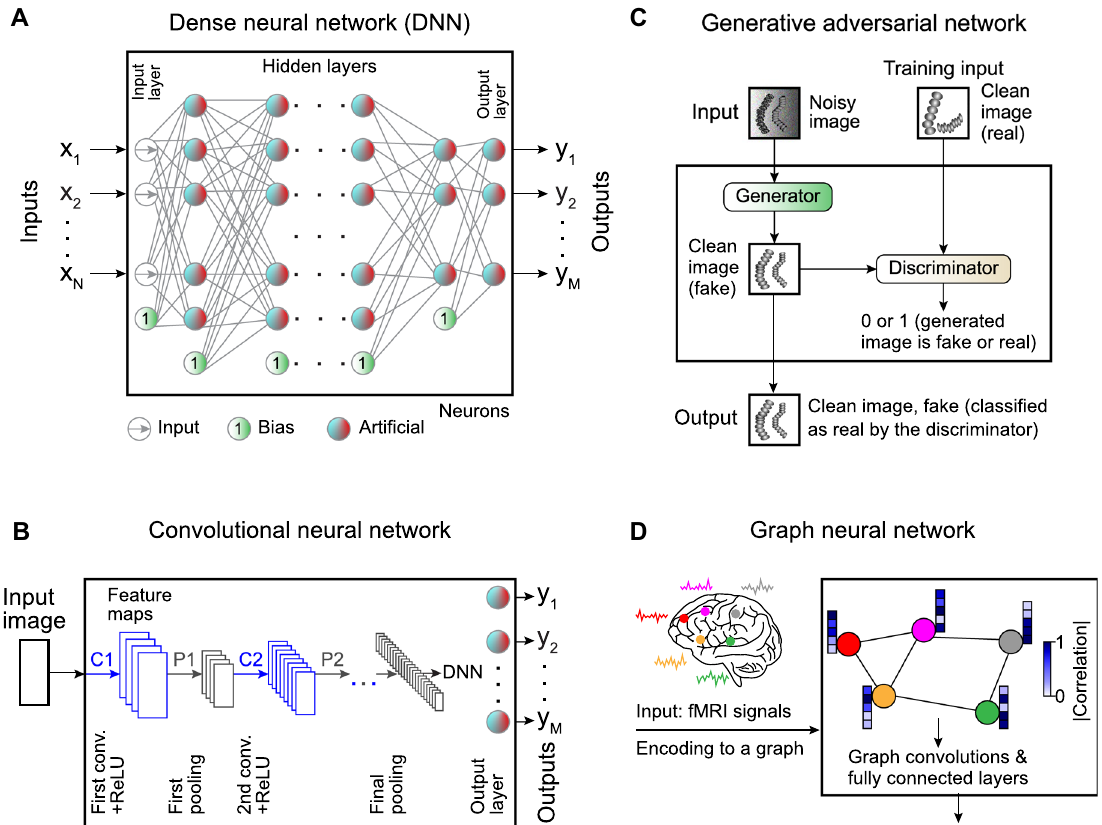
Figure 2: Commonly employed neural